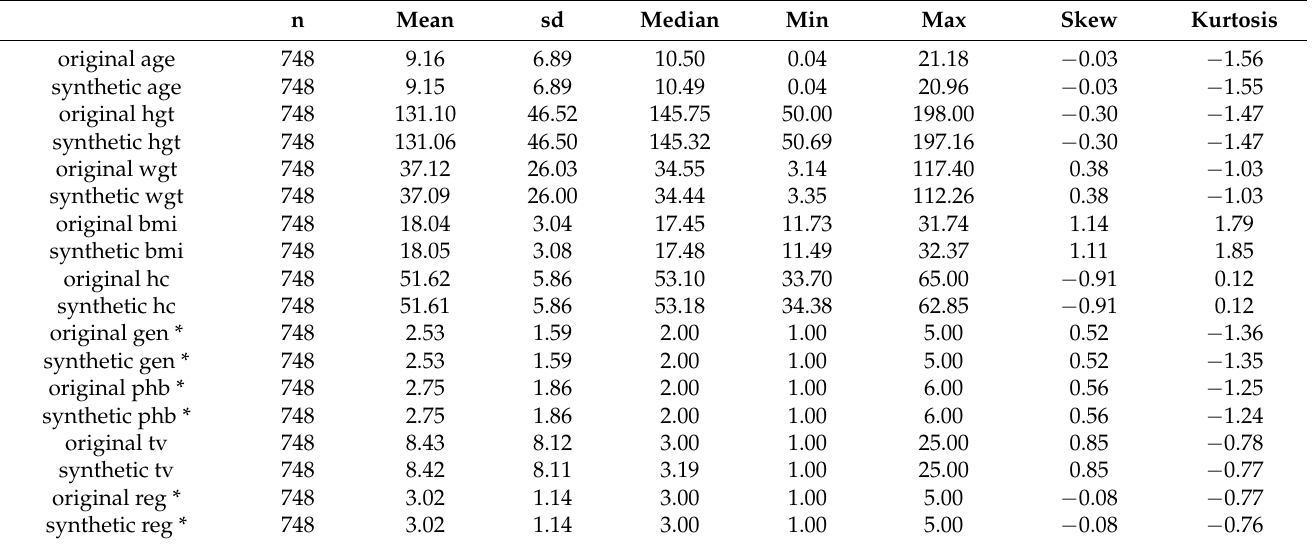
Table 2. Univariate descriptives for the true data and m = 5 pooled univariate descriptives for the synthetic data over 1000 simulations. Variable names followed by an asterix (*) are categorical. n